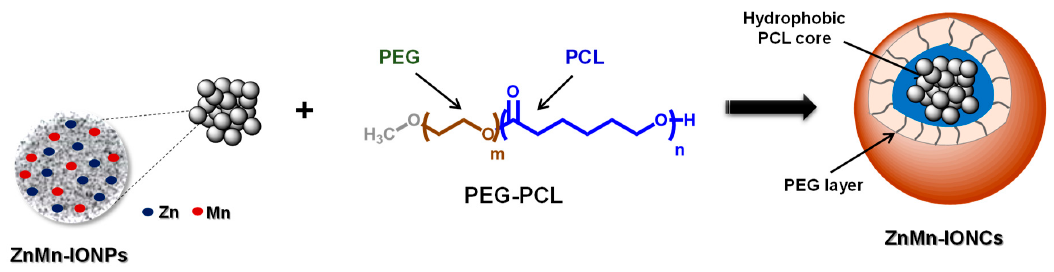
Figure 1. Scheme for nanocluster preparation. To prepare nanoclusters, iron oxide nanoparticles doped with Zn and Mn (ZnMn-IONPs) were encapsulated into the hydrophobic core of a PEG-PCL-based nanocarrier.